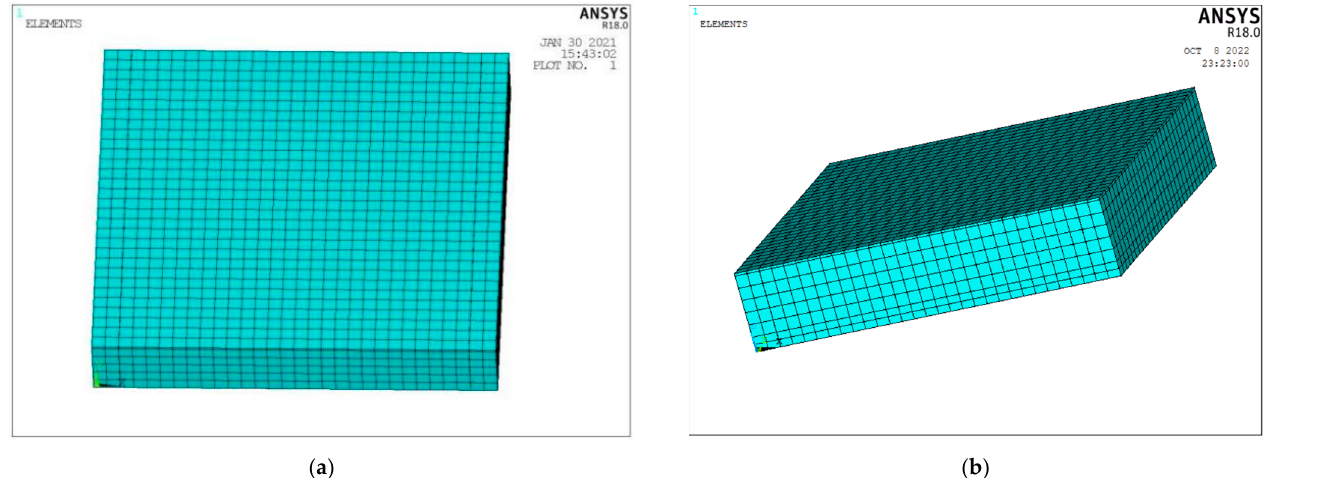
Figure 12. Mesh division of the melting ice model. ( a ) Grid division with heat insulation model; ( b ) Meshing without heat insulation model.